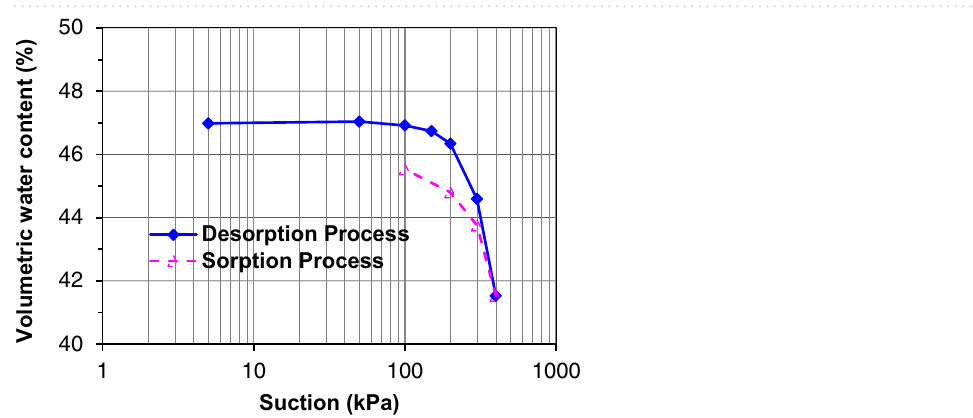
Figure 2. Particle size distribution curve.